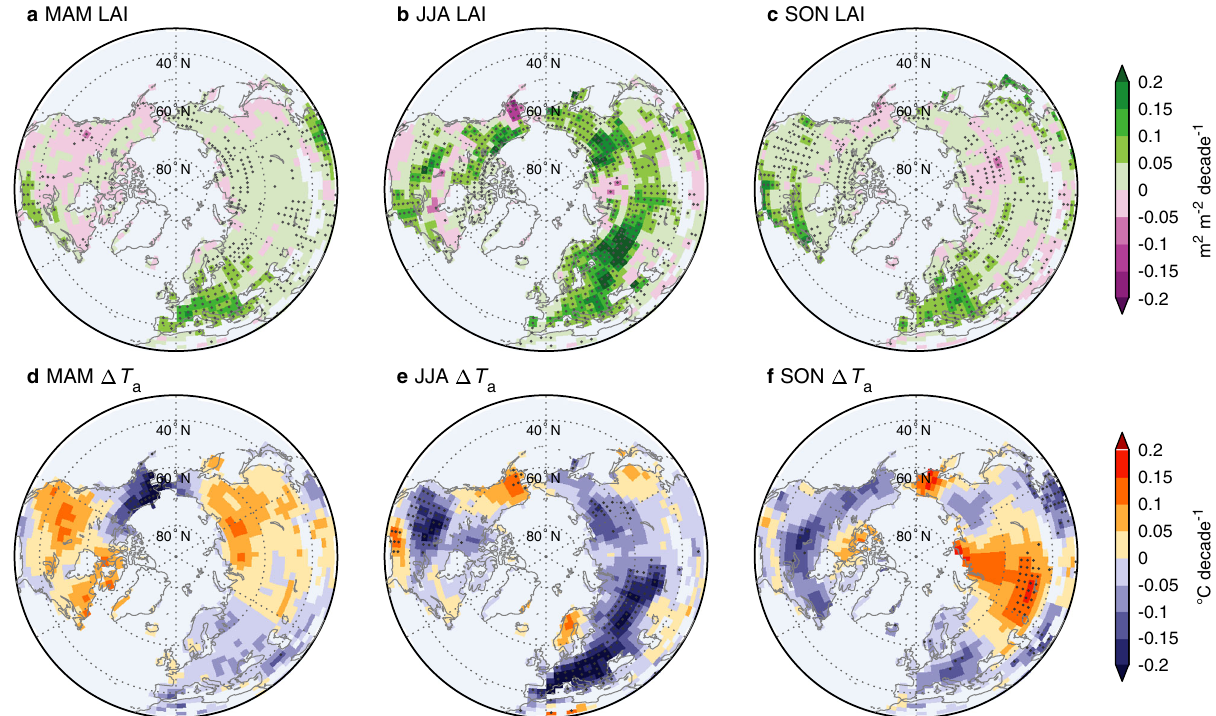
Fig. 2 Spatial patterns of intra-seasonal temperature responses to leaf area index (LAI) changes. Maps of linear trends in seasonal LAI ( a – c ) and the induced air temperature changes ( Δ T a ) in the corresponding season ( d – f ) during 1982 – 2014. Δ T a values re fl ect the differences in results between the dynamic vegetation experiment (SCE) and the three seasonal control experiments (LAI MAM is statistically signi fi cant ( p < 0.05). Pixels with climatological LAI < 0.1 are masked. MAM March-April-May, JJA June-July-August, SON September- October-November, DJF December-January-February.